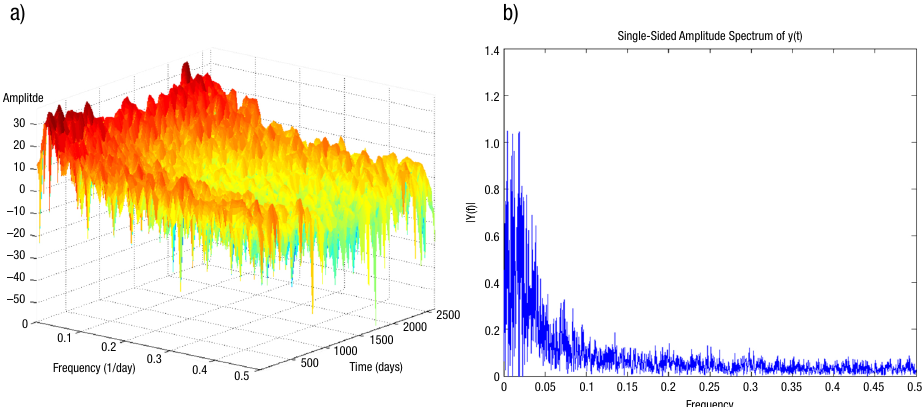
Fig. 5. International Business Machines Corporation (IBM) – 1- day period time series, spectrogram (a), spectrum (b), source: own research